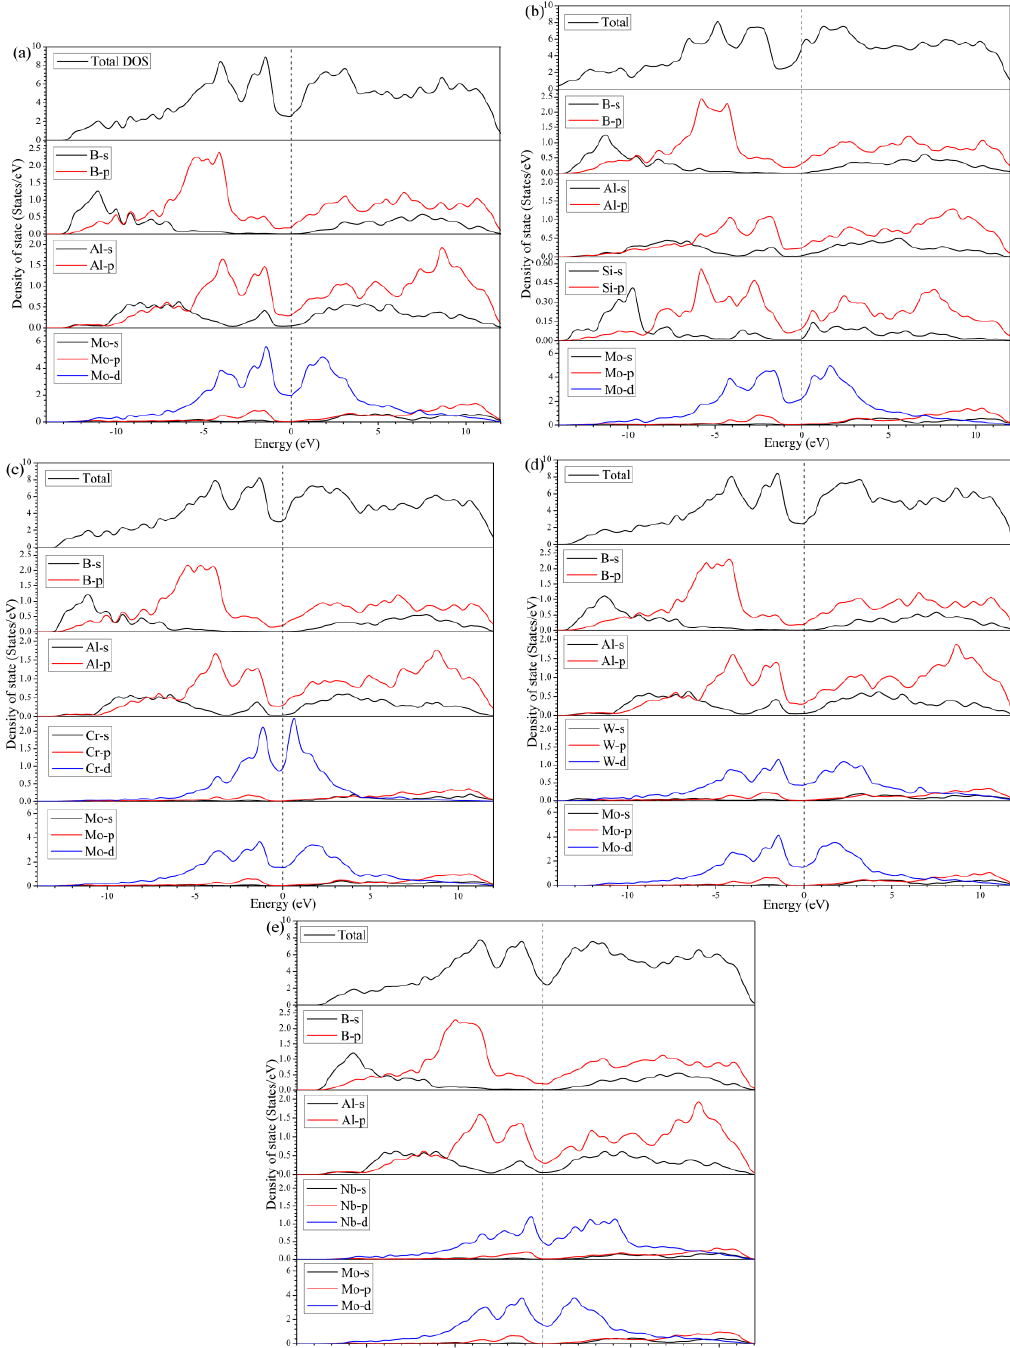
Figure 5. The total, and partial, density of states of: ( a ) Mo 4 Al 4 B 4 ; ( b ) Mo 4 Al 3 SiB 4 ; ( c ) Mo 3 CrAl 4 B 4